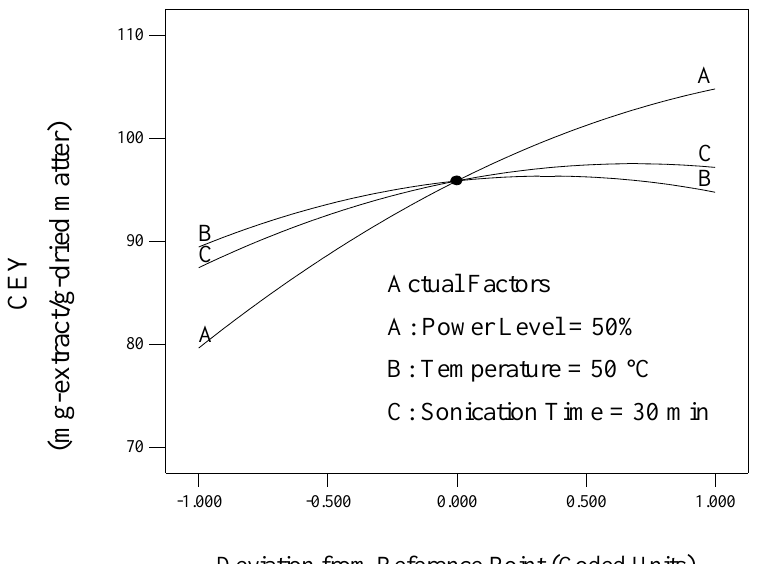
Figure 1. Perturbation graph showing the effect of process variables on crude extract